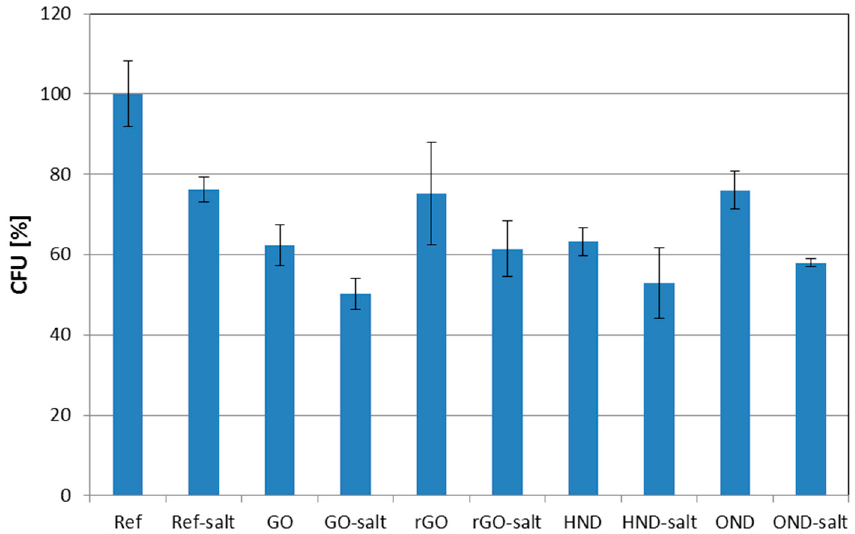
Figure 4. Effect of cultivation on salty agars on the number of CFU after 24 h of exposure to nanomaterials in the LB